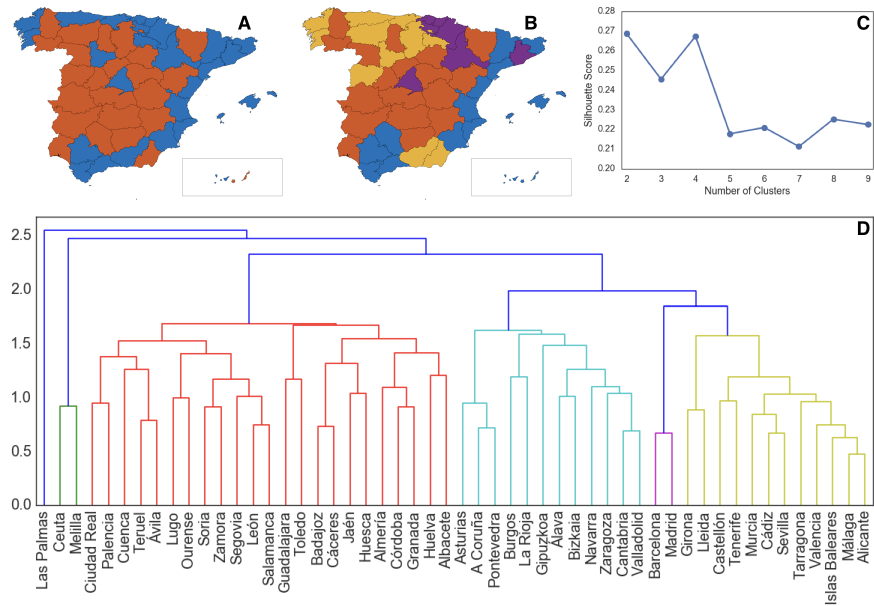
Fig 2. Cluster of provinces based on micro-socioeconomic indices. (A) k -means clustering with two clusters. (B) k -means clusteringwith four clusters. (C) The silhouettescore for using different clusters in k - means clustering. (D) Dendrogram of agglomerative hierarchical